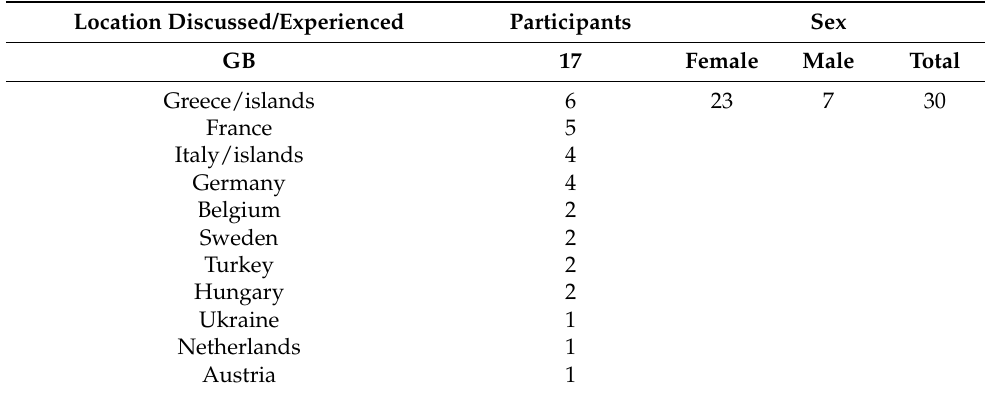
Table 1. Initial participant data up-to January